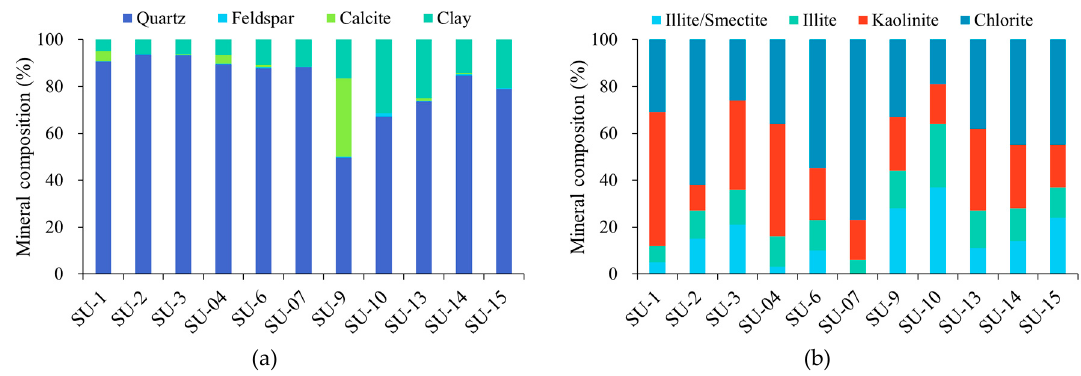
Figure 3. Mineral composition bar chart of He 8 Member tight sandstone. ( a ) Total rock mineral composition bar charts; ( b ) clay mineral composition bar charts.